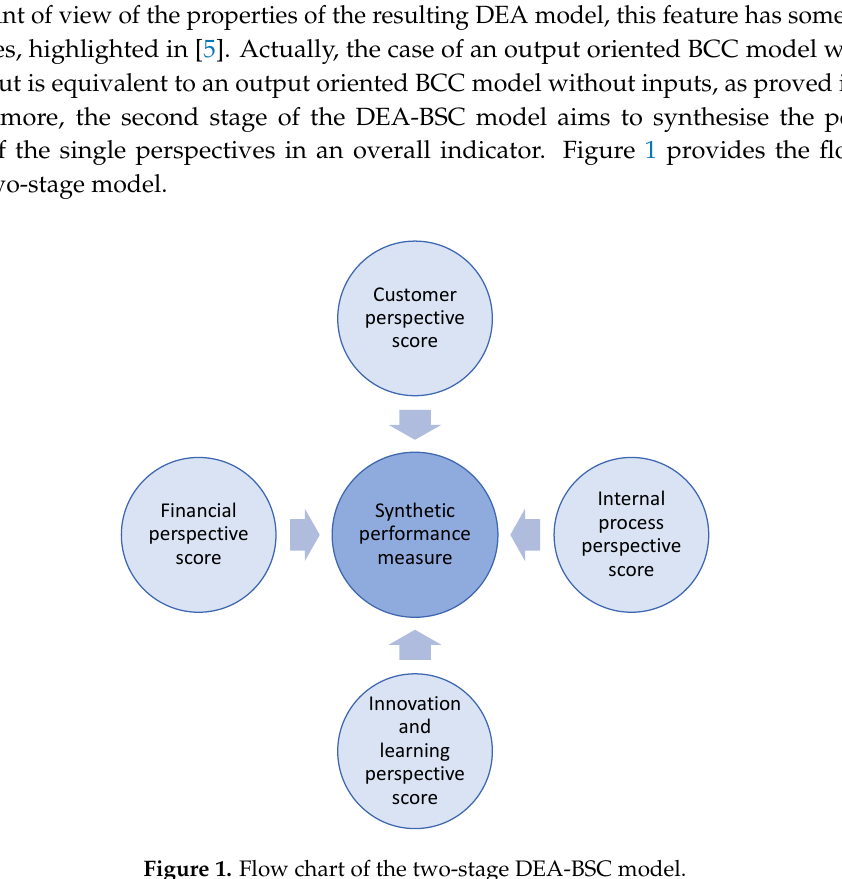
Figure 1. Flow chart of the two-stage DEA-BSC model.